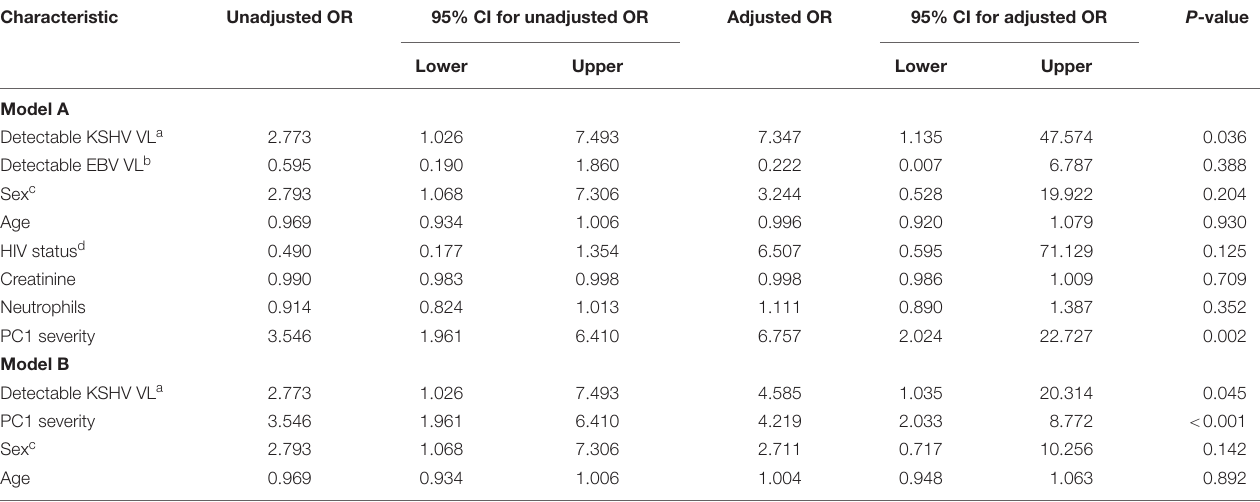
TABLE 3 | Logistic regression for death outcome in COVID-19 positive patients ( n = 104). Characteristic Unadjusted OR 95% CI for unadjusted OR Adjusted OR 95% CI for adjusted OR P -value Lower Upper Lower Upper